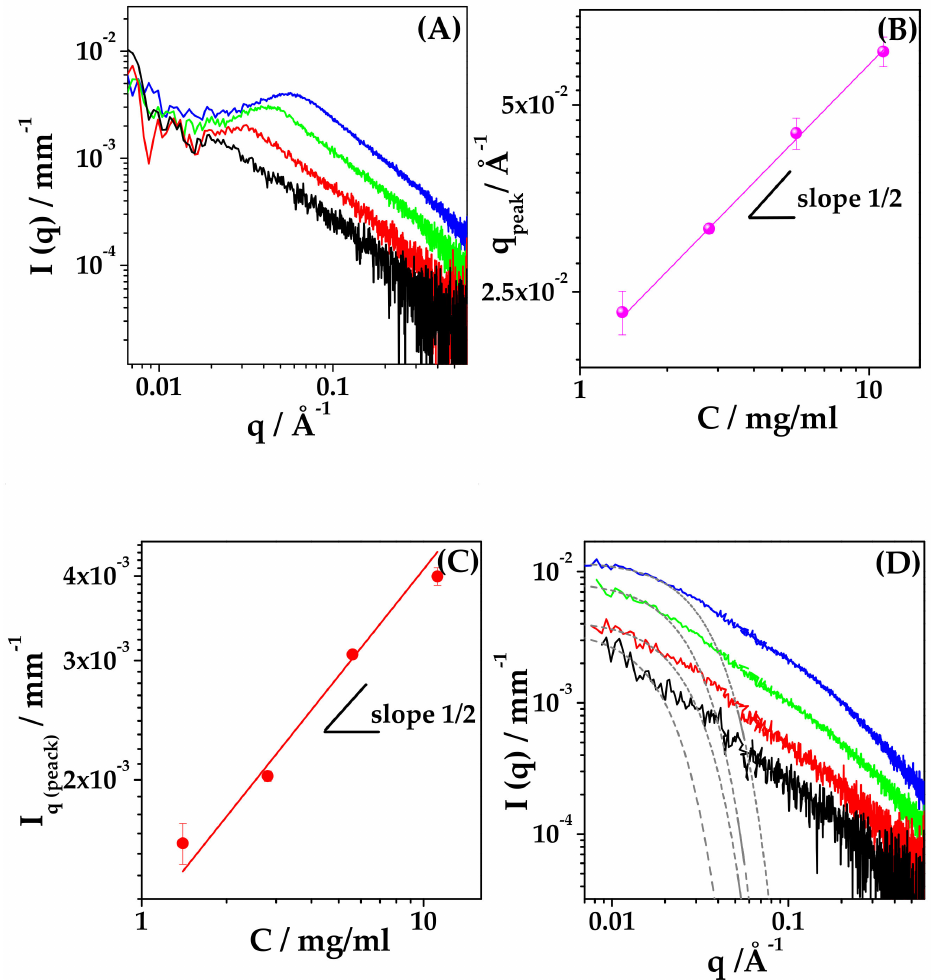
Figure 6. SAXS of HYA solution. HYA concentration: 1.4 mg/mL (black), 2.8 mg/mL (red), 5.6 mg/mL (green) and 11.2 mg/mL (blue). Water: ( A ) Intensity profiles at increasing concen- tration; ( B ) Scaling behaviour of the correlation peak position (q peak ); ( C ) Scaling behaviour of the scattered intensity at q = q peak , I (q peak ). PB: ( D ) Intensity profiles for HYA in PB (138 mM salt concentration) and the corresponding Guinier Fit (gray dash